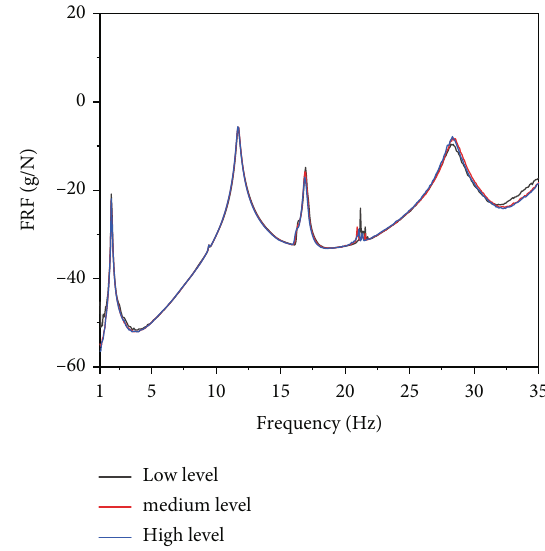
Figure 8: The sum FRF measured at di ff erent level excitation of the main